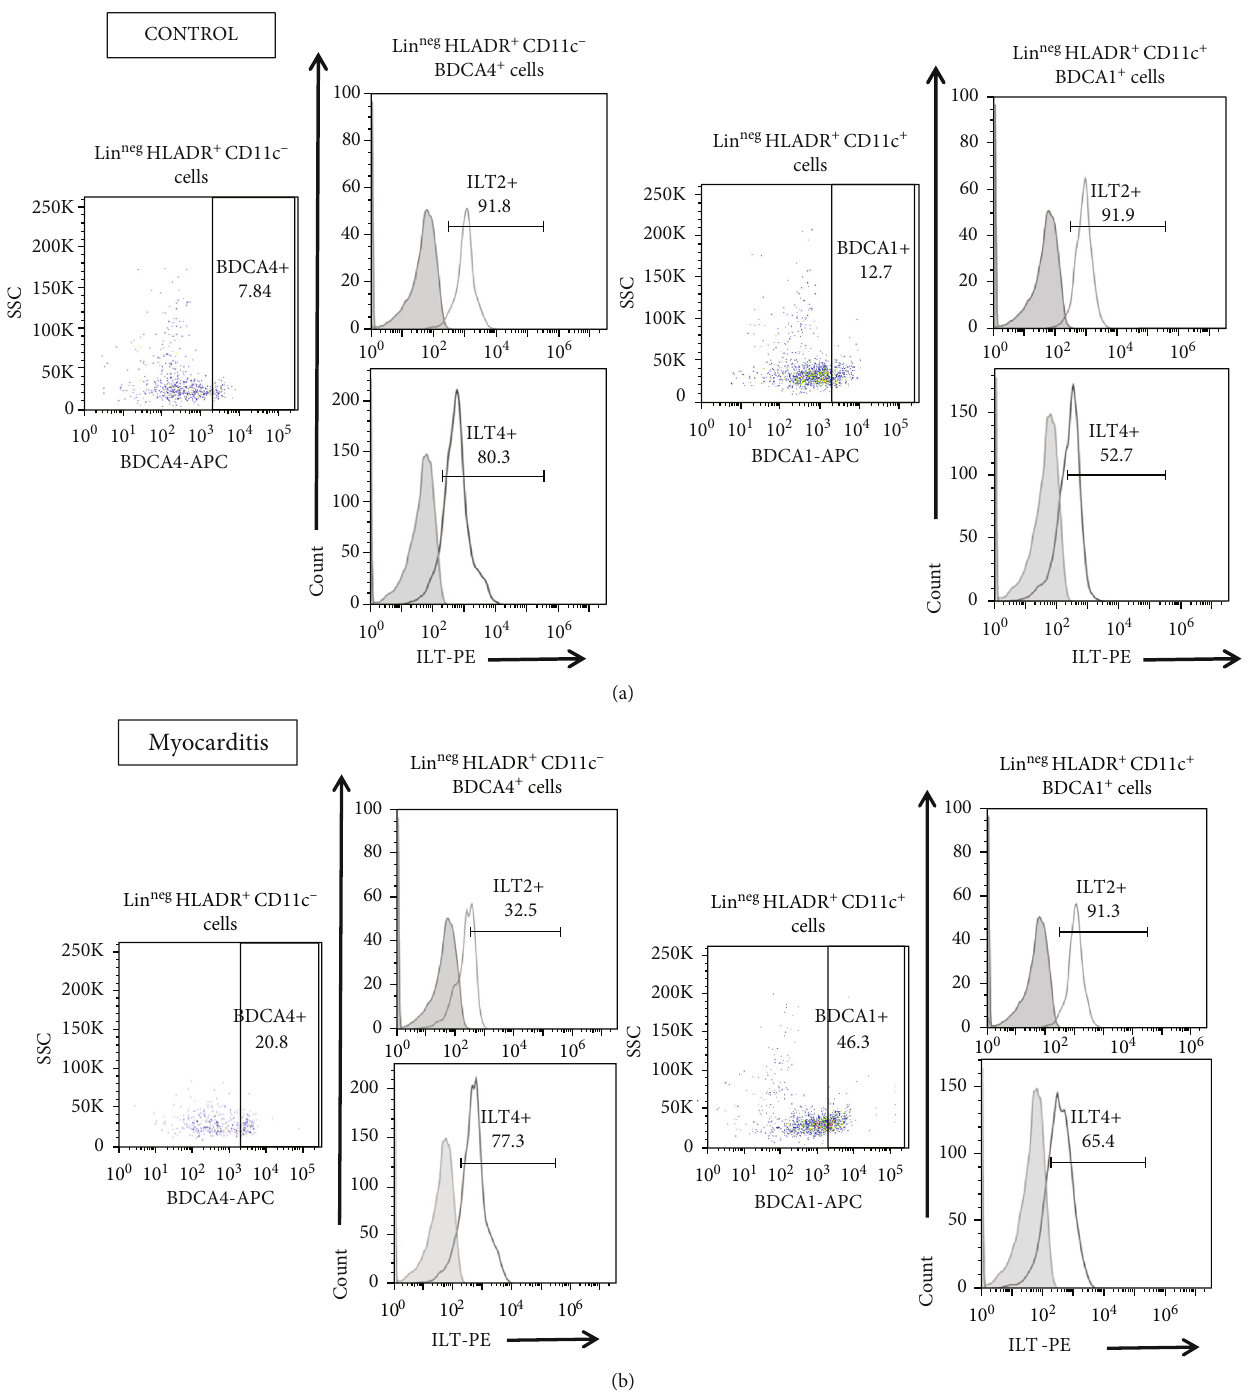
Figure 3: Expression of ILT2 and ILT4 in DCs from myocarditis and control subjects. Multiparametric fl ow cytometry gating tree for lineage negative (LINneg), HLA − DR + CD11c + , BDCA1+ ILT2+ or ILT4+ cells (mDCs) and (LINneg), HLA − DR + CD11c − , BDCA4+, and ILT2+ or ILT4+ (pDCs). Gating tree for the analysis of the expression of ILT2 and ILT4 in myeloid dendritic cells and plasmacytoid dendritic cells in PBMC from a control subject (a) and (b) a myocarditis patient. Myeloid dendritic cells showed similar percentages of ILT2 and ILT4 positive DCs compared with healthy volunteers (Figures 4(b) and 4(d)). Interestingly, myeloid DCs from myocarditis patients displayed higher surface expression (MFI) of ILT4 compared to controls ( p = 0 : 03 , Figure